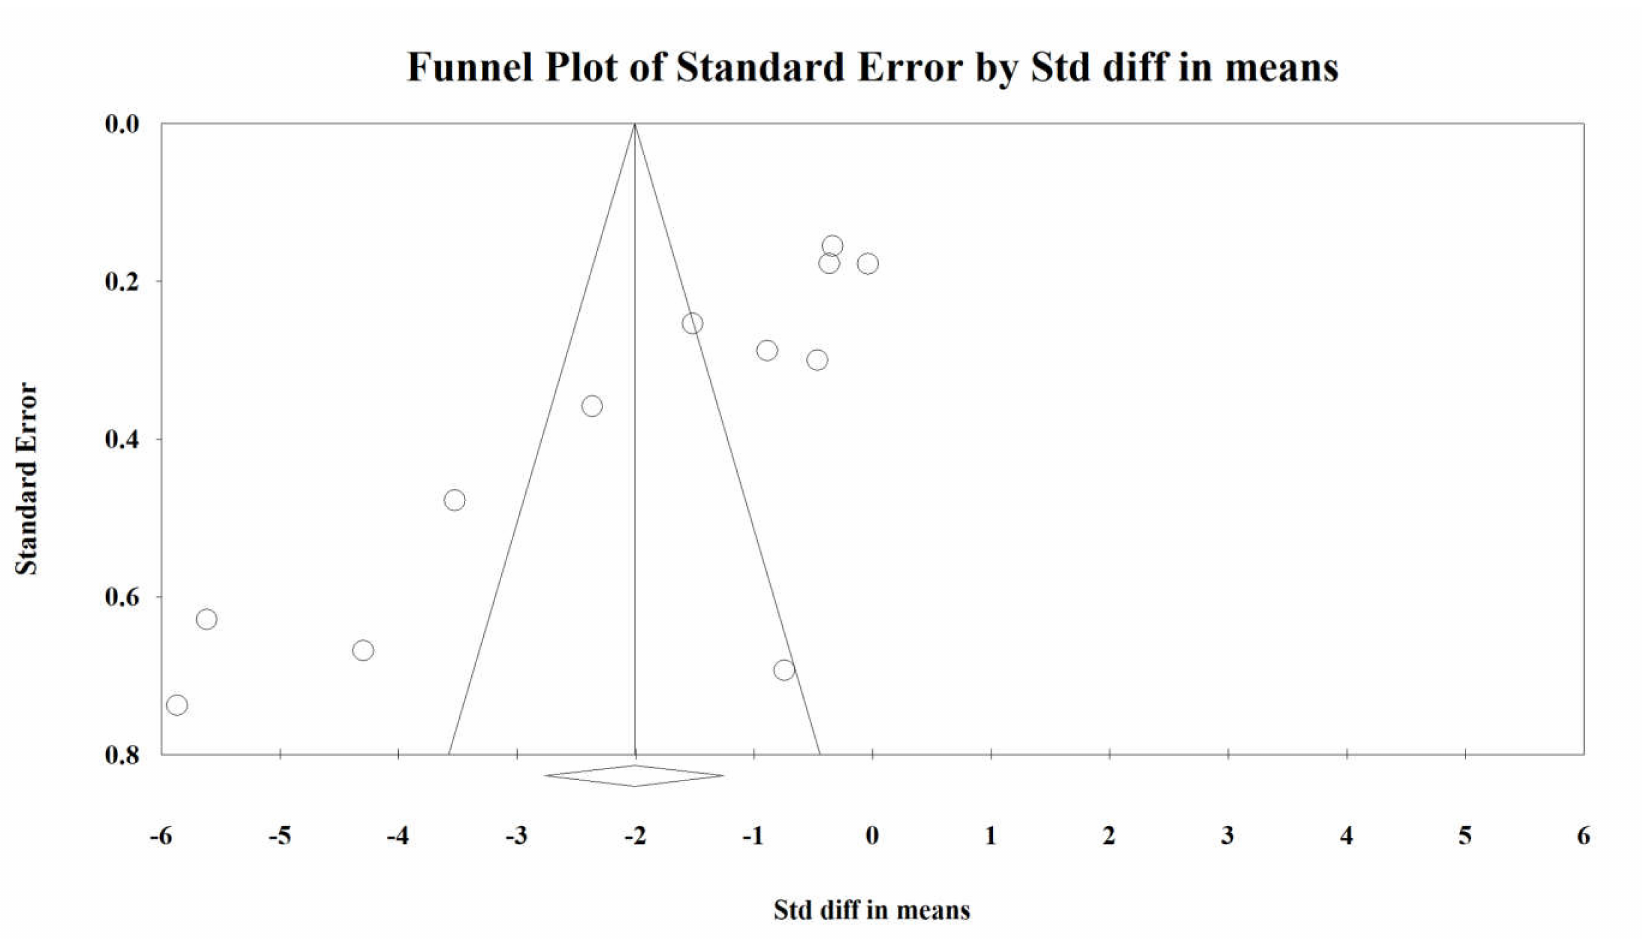
Figure 4. Funnel plot for crying time (SMD) in present